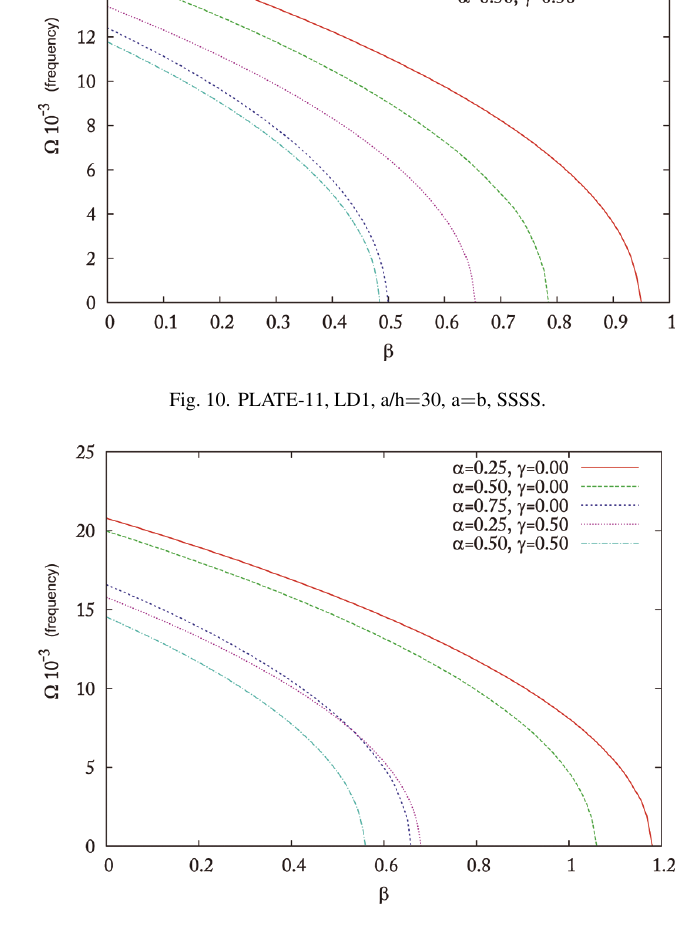
Fig. 11. PLATE-13 ( θ = 45 ◦ ), LD1, a/h = 30, a = b,